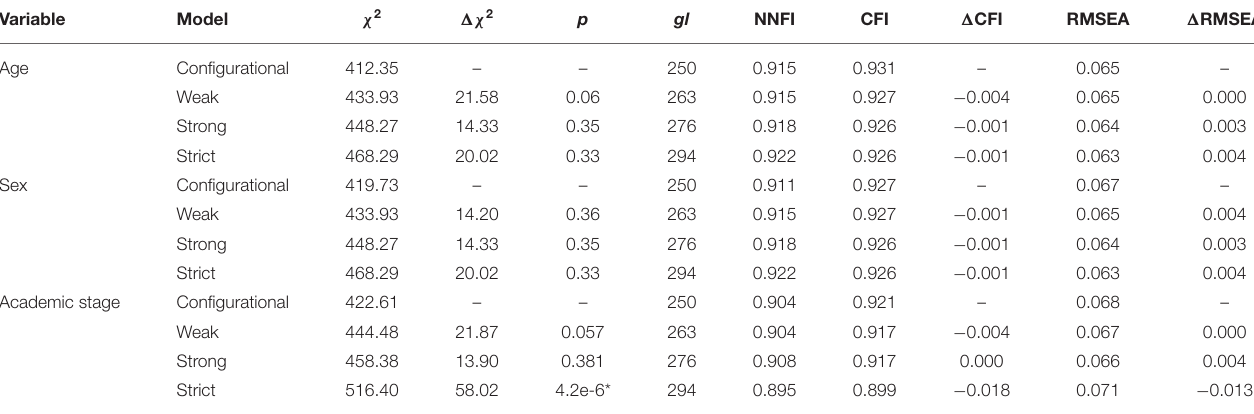
TABLE 4 | Fitness indices for assessing the factorial invariance of the EDDPsic. Variable